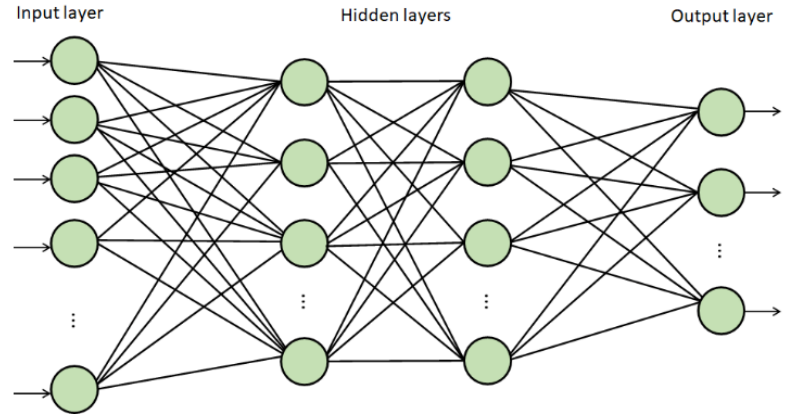
Figure 1. Illustration of an artificial neural network.